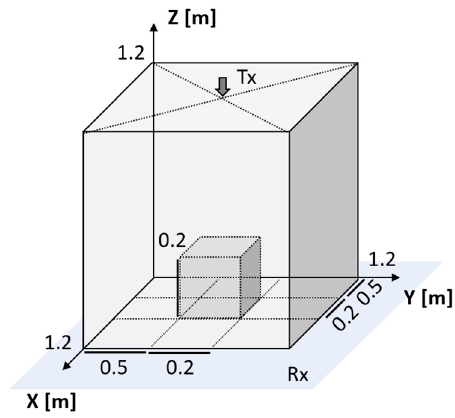
Figure 4. Illustration of simulation setup of an inside box and outside box shield in the near-field of an infinitesimal point magnetic dipole. T x and R x represent a transmitter of the dipole and receiver. The receivers are located on the light blue plane and negative z-direction. The thickness of the outside shell is 2.7 mm.